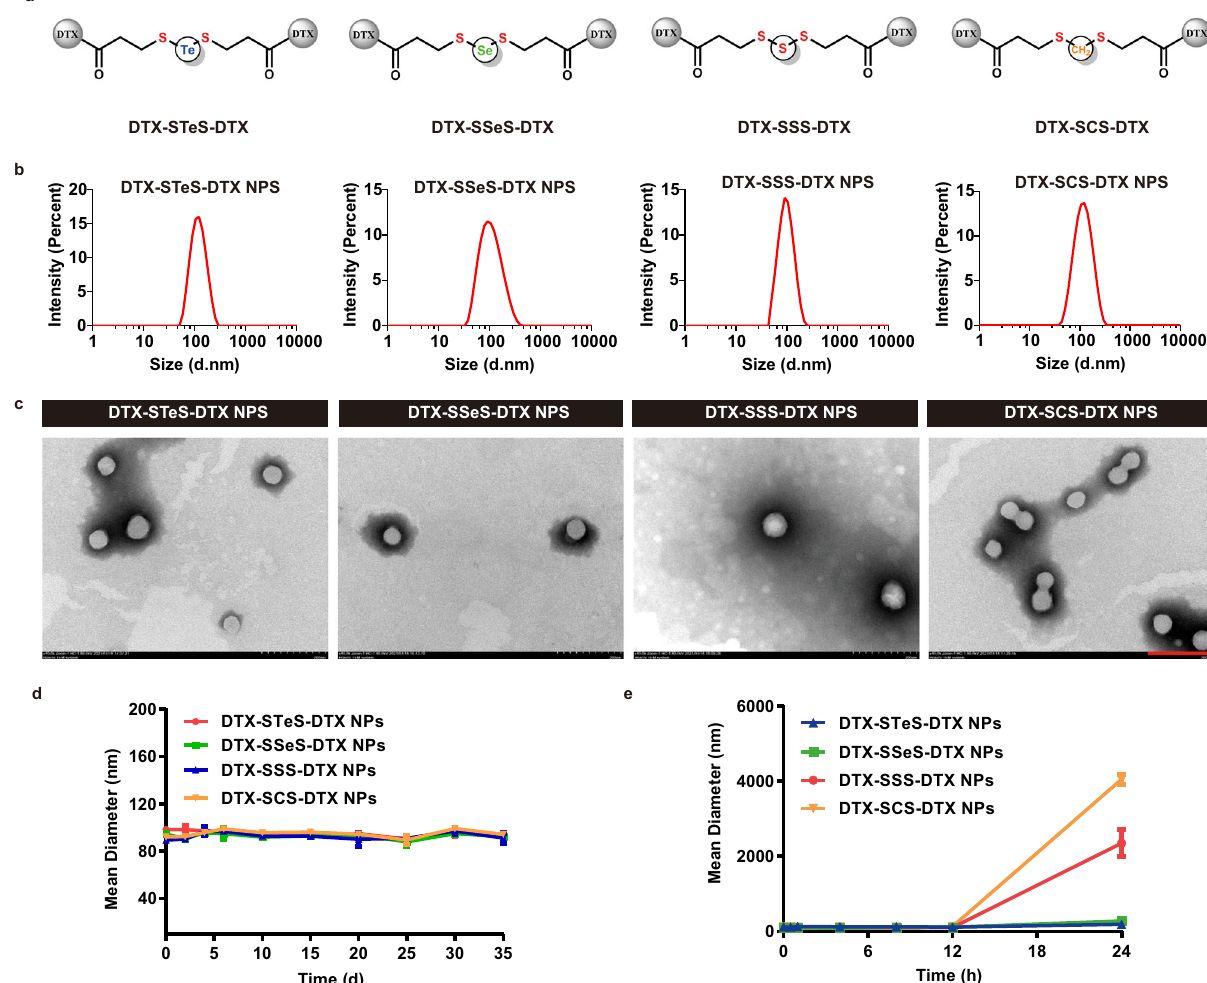
Fig.2|PreparationandcharacterizationofHPNAs.a ChemicalstructuresofDTX homodimeric prodrugs. b Particle size distribution of HPNAs. Source data are provided asaSourceData fi le. c Morphologyof HPNAsobtainedbyTEM.Scale bar represents 200nm. Experiment was repeated three times independently with similar results. d Storage stability of HPNAs at 4°C. Data are presented as